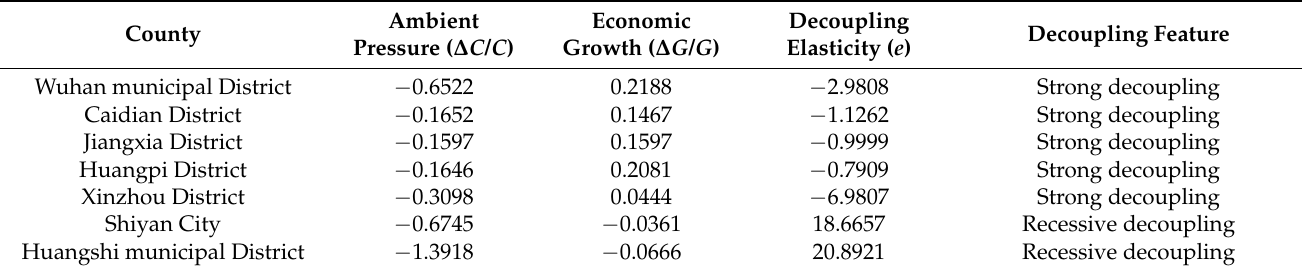
Table A4. Decoupling characteristics of carbon emissions and agricultural economic growth